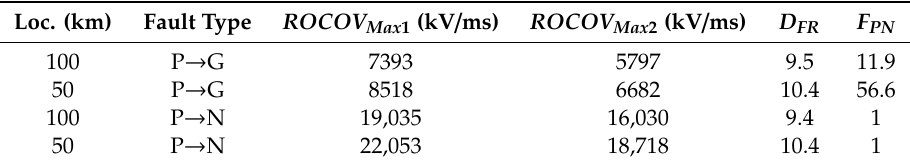
Table 5. Identifying faults in Zone-A at R AI .